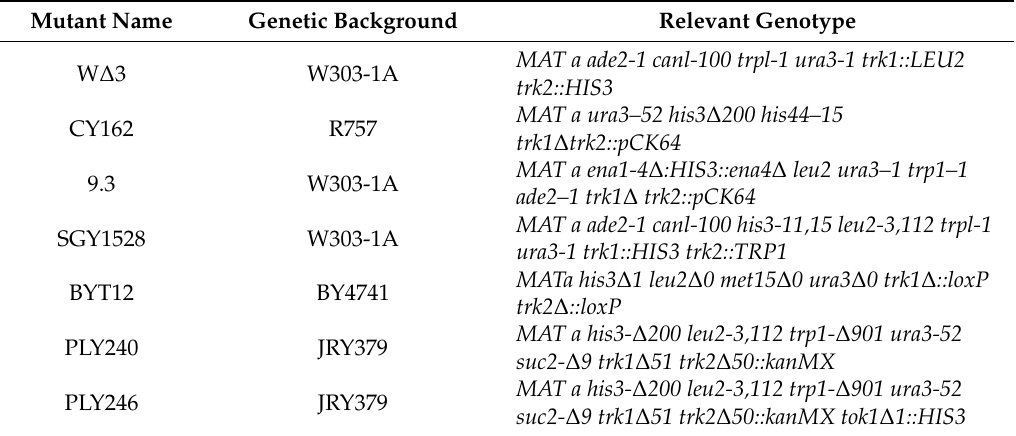
Table 1. Yeast stains used for cloning and functional complementation of plant K + channels. All strains lack the TRK1 and TRK2